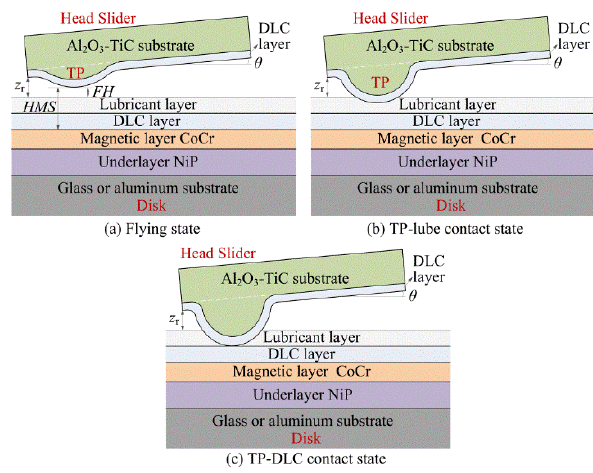
Figure 1. Schematic showing of the head–disk interface (HDI): ( a ) Flying state, ( b ) Thermal protrusion–lubricant (TP–lube) contact state, and ( c ) Thermal protrusion–diamond–like carbon (TP–DLC) contact state.